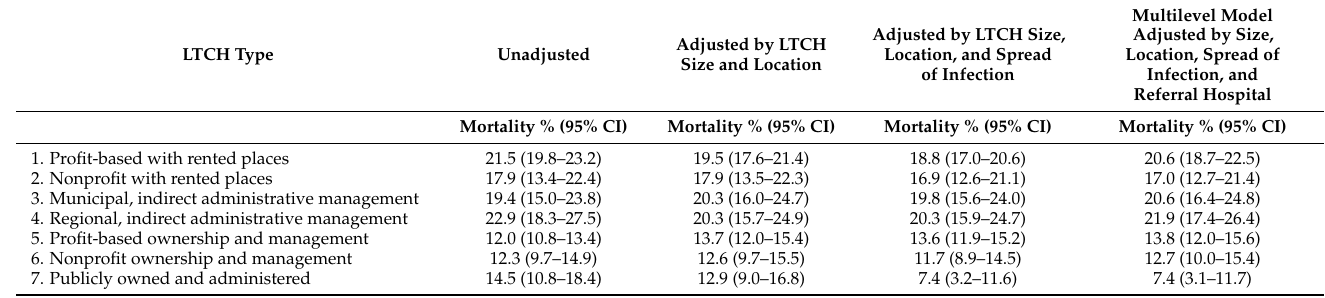
Table 4. Estimated mortality by LTCH type in the Community of Madrid, March–April 2020.